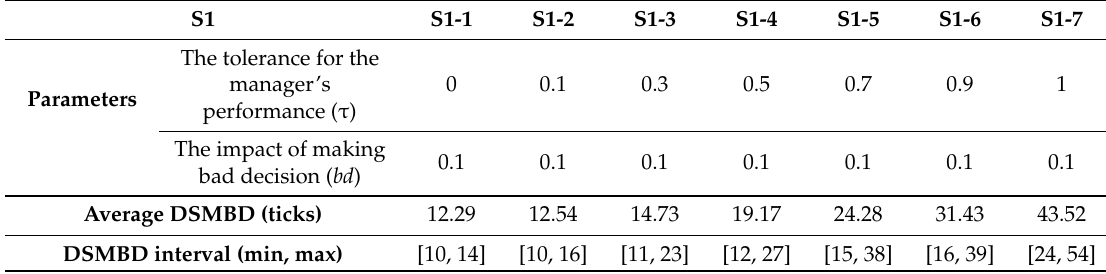
Table 6. Simulation’s results for S1 when bd =